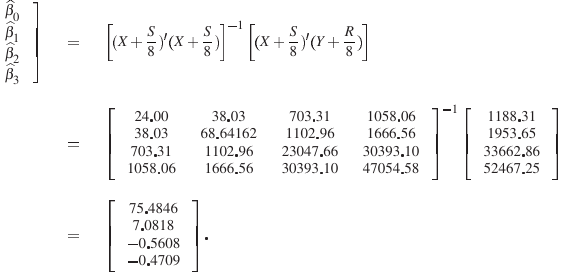
Table 4. SomemeasuredsoilprotectioninExample3. i